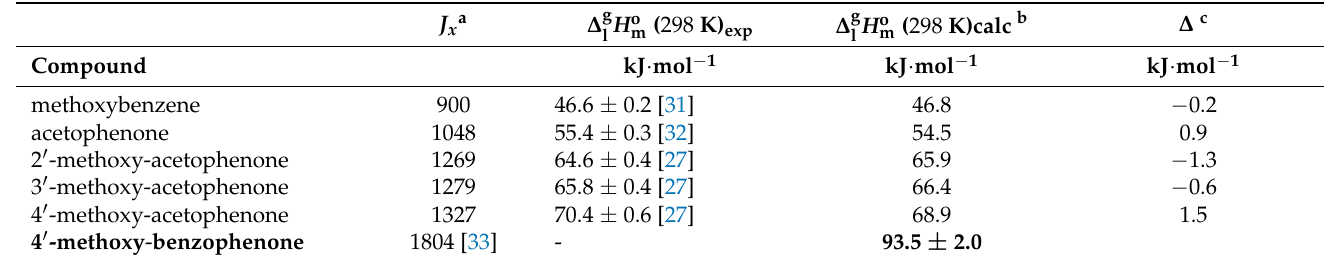
Table 5. Correlation of vaporisation enthalpies, ∆ g derivatives with their Kovats indices ( J x